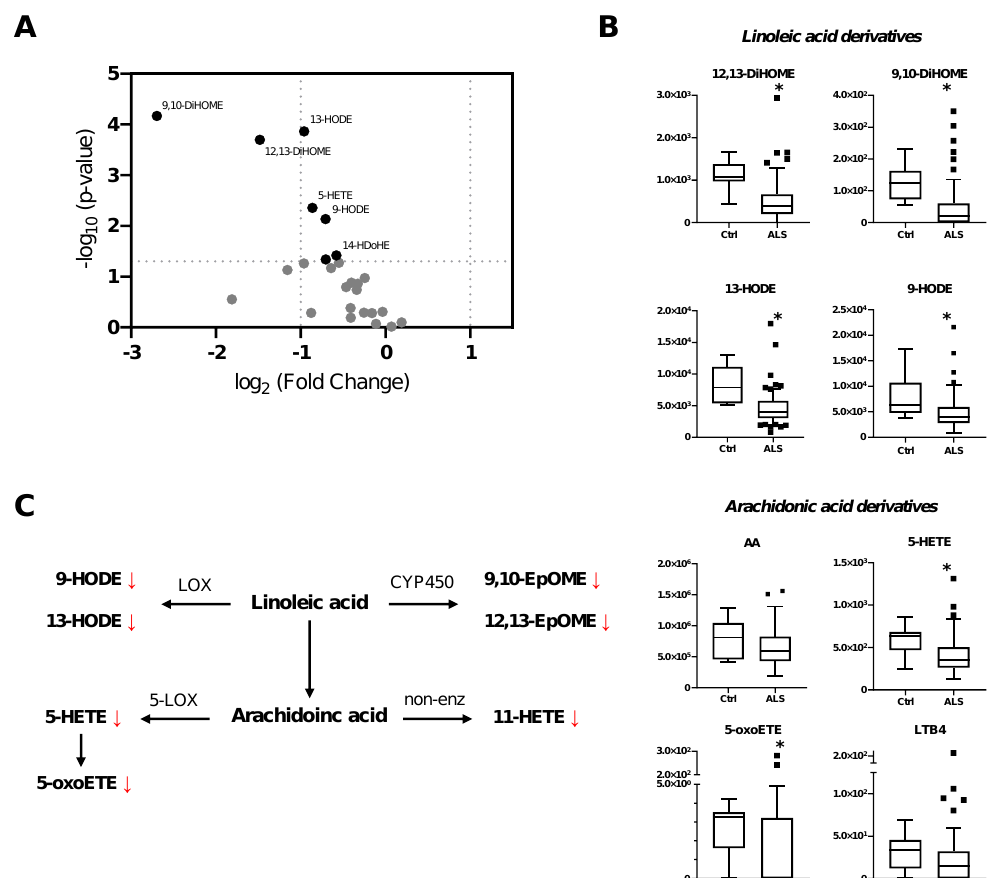
Figure 1. Individual oxylipin analysis. ( A ) Volcano plot representation indicating the − log 10 ( p -value) and the log 2 (fold change) of the oxylipin concentration in plasma for ALS vs. Control group shown in Table 1. Dots in black represent p < 0.05. ( B ) Tukey plot for plasma concentration (pg/mL) of selected oxylipins in Control (Ctrl) and ALS patients (ALS). Upper panels, LA-derived metabolites were detected and a significant decrease is shown for ALS plasma samples. Lower panels, arachidonic acid, and 5-lipoxygenase-derived metabolites plasma concentration. ( C ) Scheme representing major altered oxylipin pathways in plasma of ALS patients. Significantly altered metabolites are derived from LOX and CYP450 pathways. * p < 0.05, Mann – Whitney test.